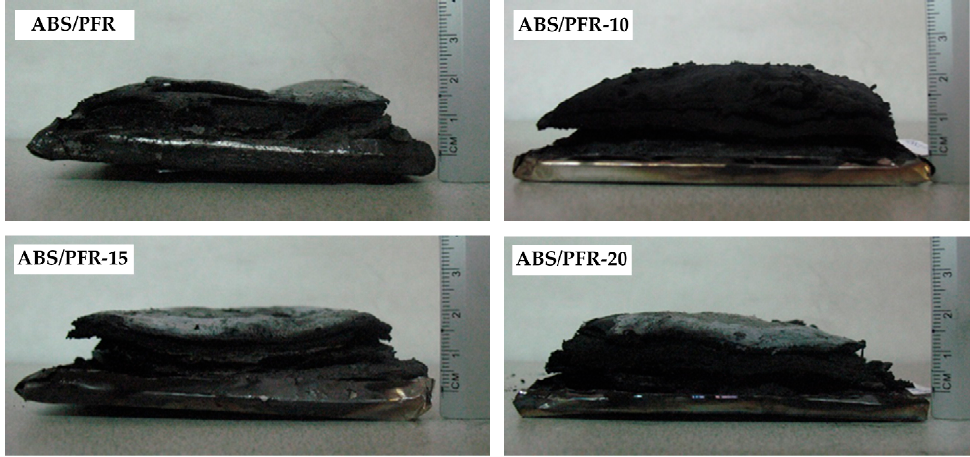
Figure 14. Residues of unfoamed and foamed ABS/PFR parts after the cone calorimeter tests.